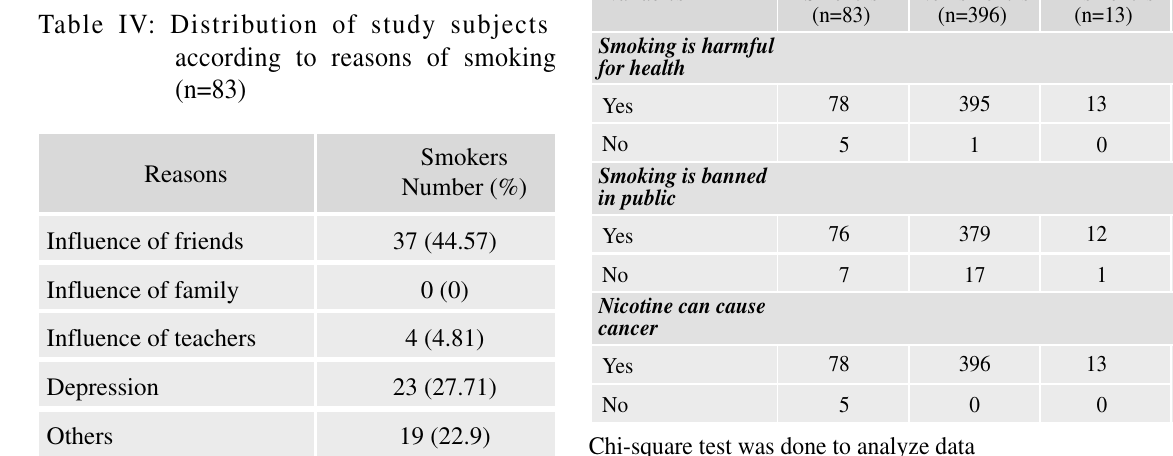
Table IV: Distribution of study subjects